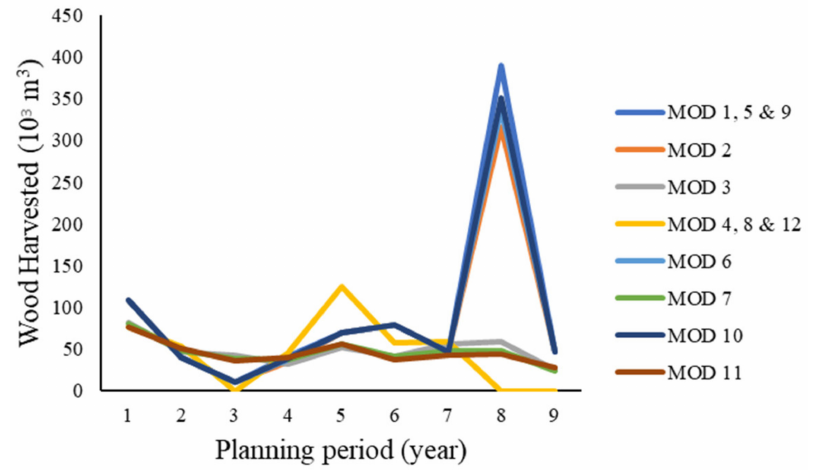
Figure 2. Annual harvested wood by decision scenario.